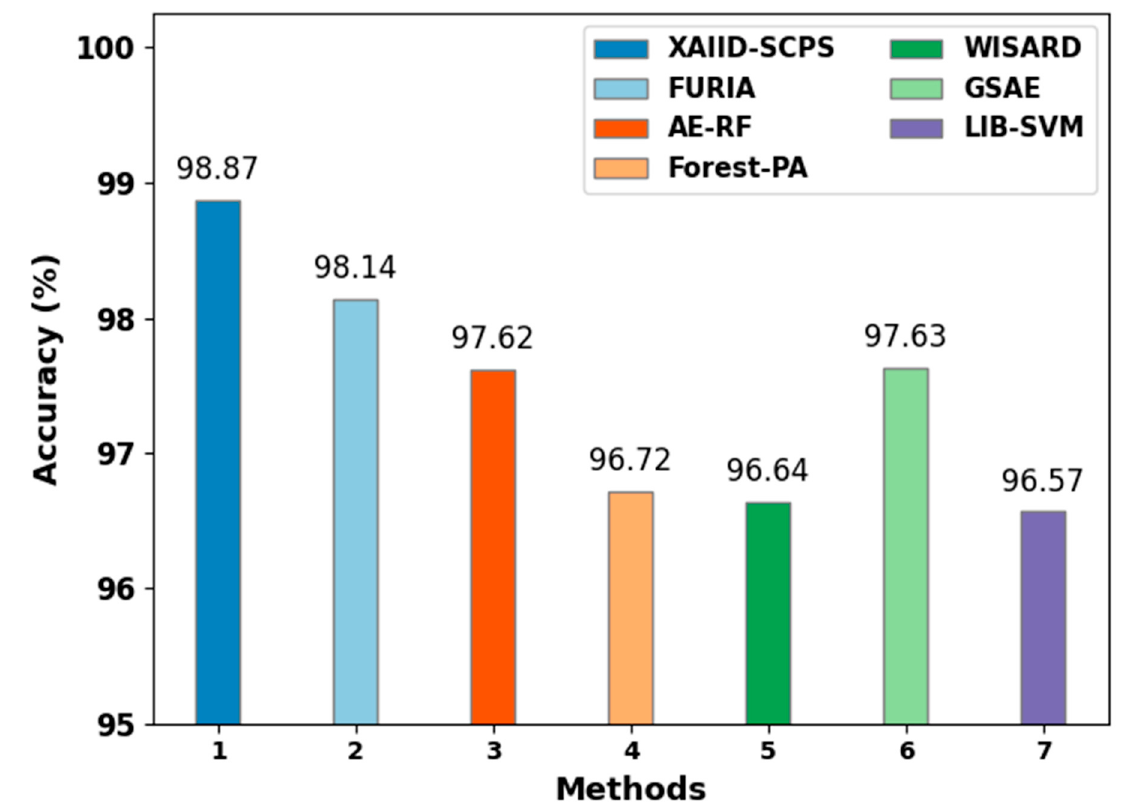
Figure 9. Accu y outcome of XAIID-SCPS system with other Figure 9. 𝐴𝑐𝑐𝑢 (cid:3052) outcome of XAIID-SCPS system with other systems Meanwhile, based on 𝑝𝑟𝑒𝑐 (cid:3041) , the XAIID-SCPS method results in an increasing 𝑝𝑟𝑒𝑐 (cid:3041) of 98.95% while the FURIA, AE-RF, Forest-PA, WISARD, GSAE, and LIB-SVM models reach a reducing 𝑝𝑟𝑒𝑐 (cid:3041) of 97.57%, 97.35%, 96.97%, 97.58%, 95.97%, and 96.96%, respec- tively. Eventually, based on 𝐹 (cid:3046)(cid:3030)(cid:3042)(cid:3045)(cid:3032) , the XAIID-SCPS technique results in an increasing 𝐹 (cid:3046)(cid:3030)(cid:3042)(cid:3045)(cid:3032) of 98.91% while the FURIA, AE-RF, Forest-PA, WISARD, GSAE, and LIB-SVM